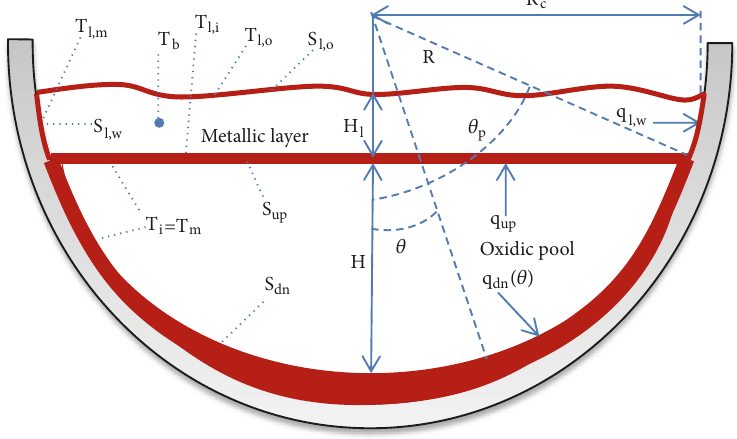
Figure 17: Graphical representation of parameters, used for solving the heat